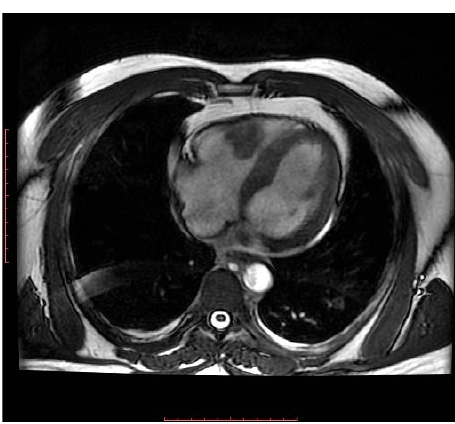
Fig. 2 - Steady-state free precession four-chamber cine view of cardiac magnetic resonance imaging demonstrating an apical obliteration of the right ventricle with a mass-like appearance protruding into the cavity from the right ventricular free wall. Note the pericardial effusion.